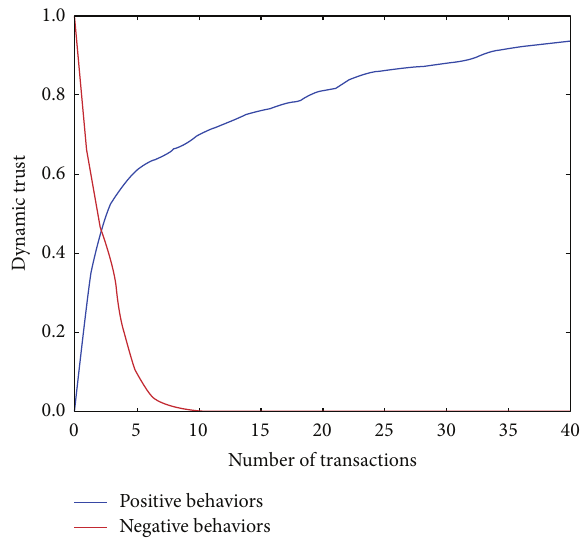
Figure 2: Dynamic trust by